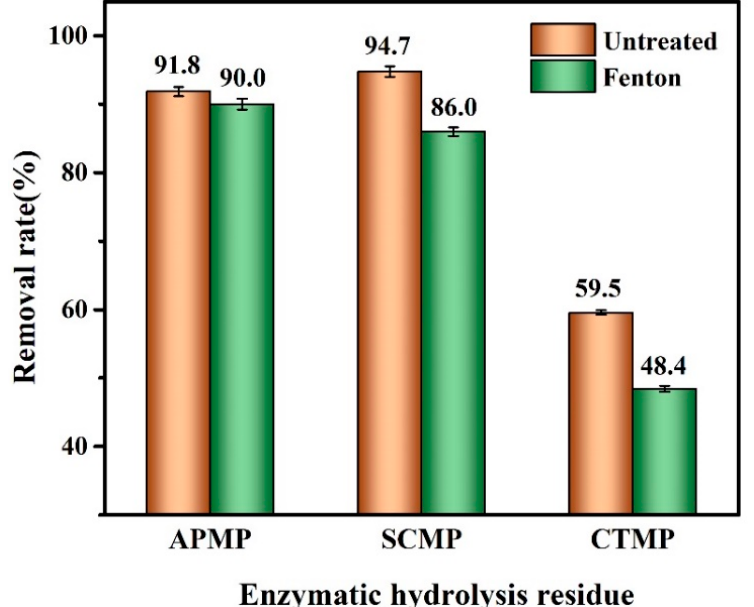
Figure 7. The removal rate of methylene blue by the enzymatic hydrolysis